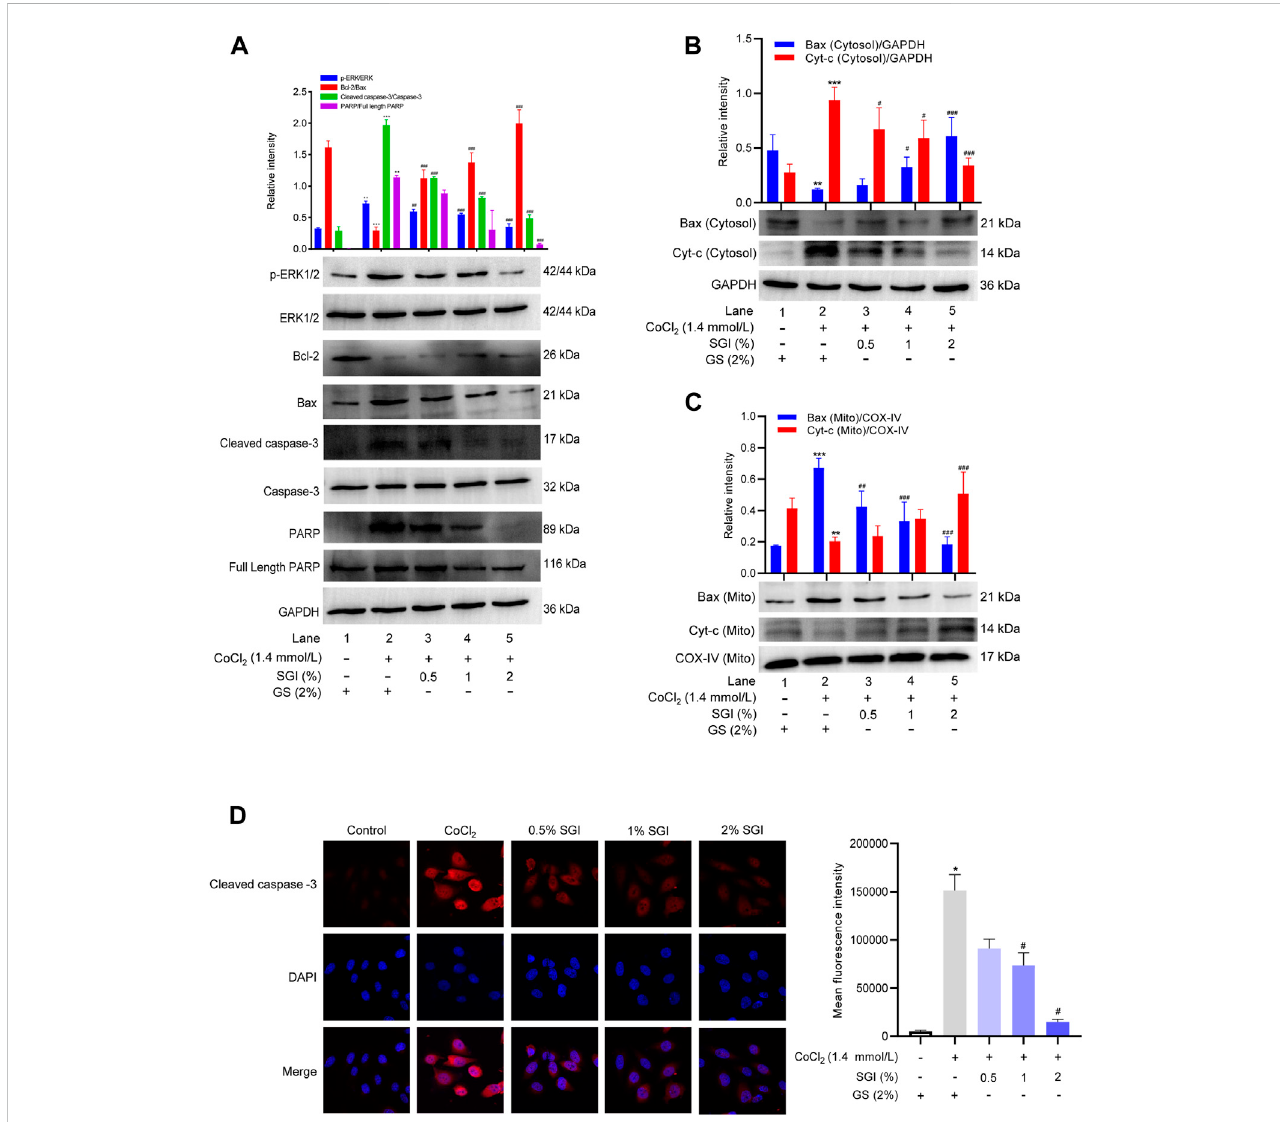
FIGURE 9 Effects of SGI on CoCl 2 -induced protein expression of HUVECs. (A) Protein expression levels of p-ERK/ERK, Bcl-2/Bax, cleaved caspase-3/Caspase- 3 and PARP/full-length PARP were measured by western blotting. Histograms represent the statistical analysis of the relative expression level of proteins. GAPDH was used as an endogenous reference. Immunoblot analysis of the expression of Cyt-c and Bax in the cytosol (B) and mitochondria (C) . (D) Immuno fl uorescencestainingofcleavedcaspase-3inHUVECs.* p < .05,** p < .01,*** p < .001vs.thecontrolgroup; # p < .05, ## p < .01, ### p < .001vs.the CoCl 2